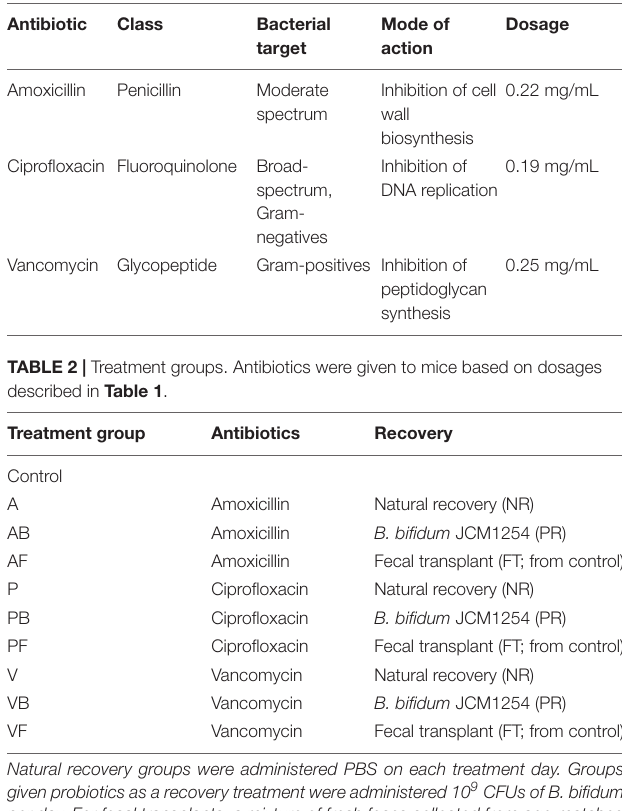
TABLE 1 | Summary of antibiotics used in the experiment.